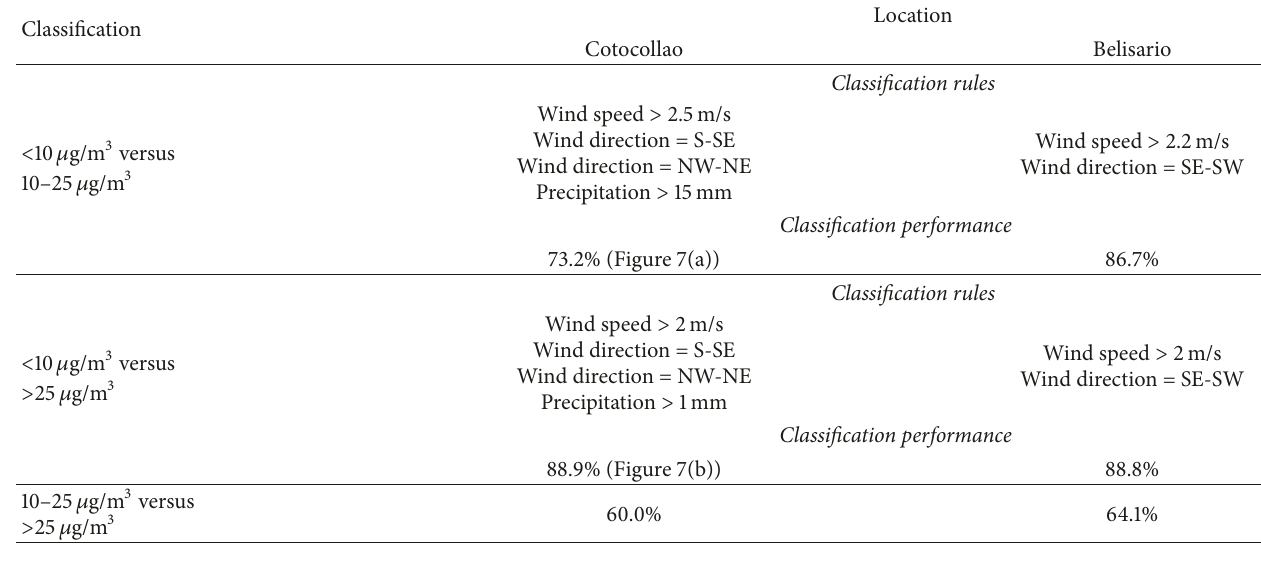
Table 6: Classification rules and pairwise comparisons between the different classes and their respective performance. Classification